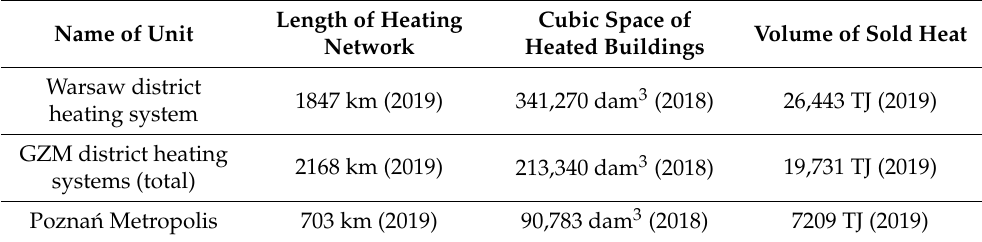
Table 1. Comparison of the Warsaw district heating system and the aggregated data on the